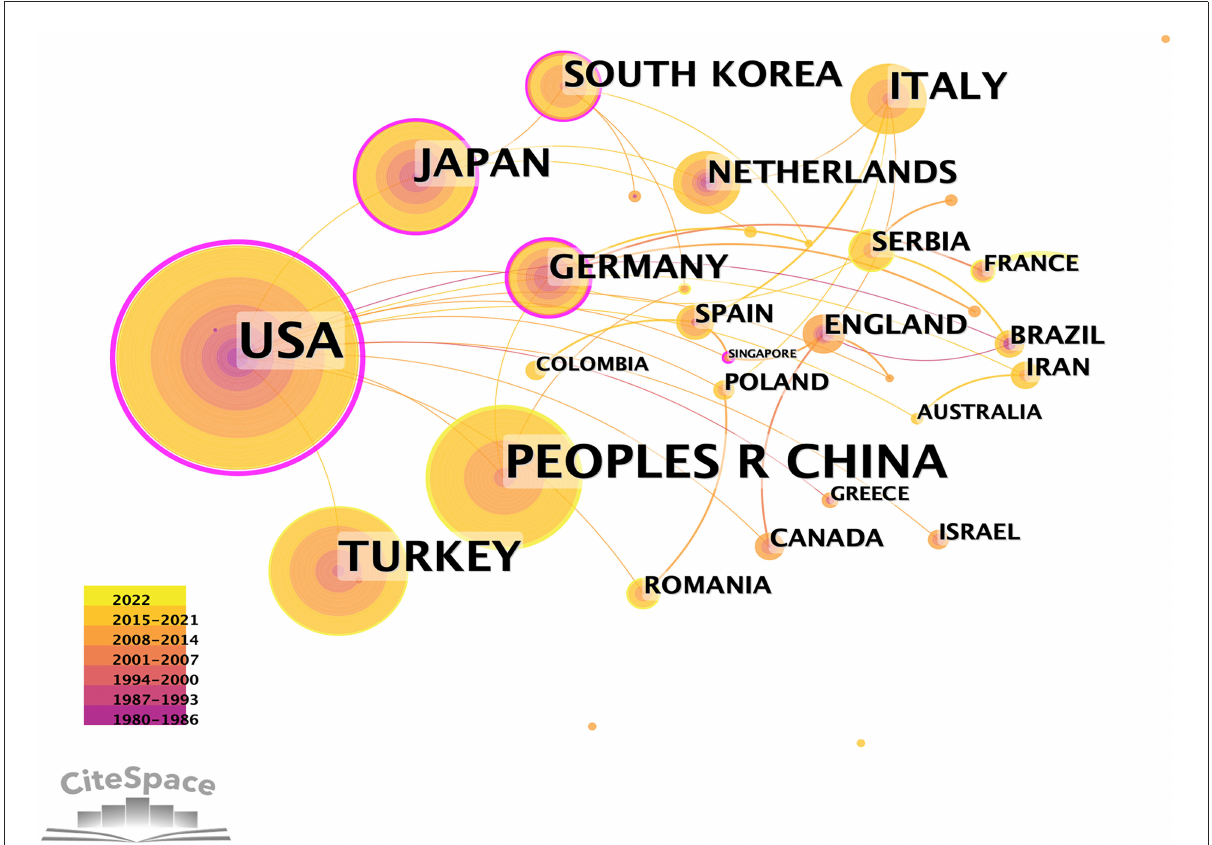
FIGURE1 Co-authorship between countries with more than five